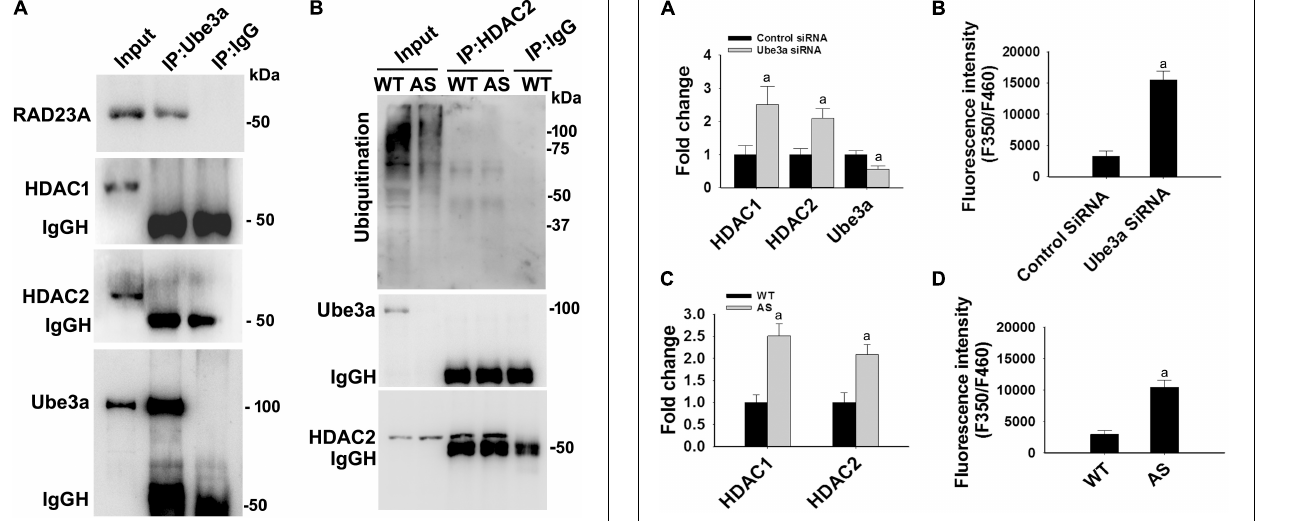
FIGURE 2 | Ube3a does not interact with either HDAC1 or HDAC2. (A) Cortical brain lysates from the wild type mice were co-immunoprecipitated with Ube3a antibody (mouse specific from Sigma) and blots were probed with Ube3a, HDAC1, HDAC2 and RAD23A antibodies. RAD23A was used as a positive control that interacted with Ube3a. (B) Brain lysates were co-immunoprecipitated by HDAC2 antibody (mouse specific from Cell Signalling Technology) and blots were detected with HDAC2, Ube3a and ubiquitin antibodies.